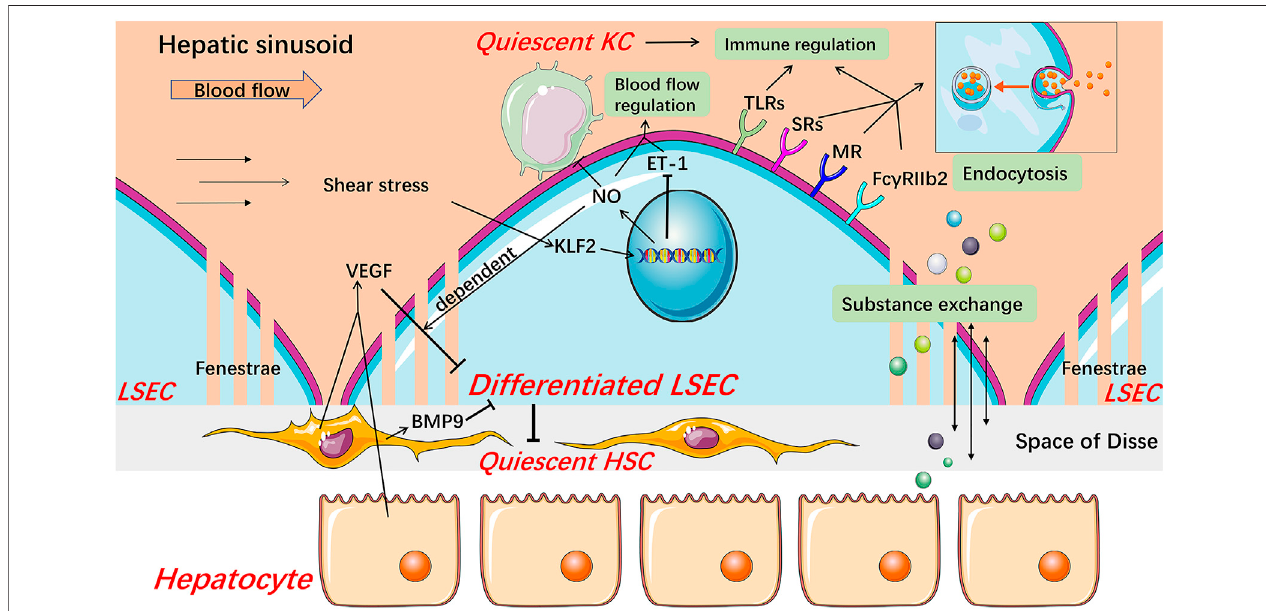
FIGURE 1 | Structure and major physiological function of LSECs. Healthy differentiated LSECs, characterized by the fenestrated phenotype and lack of basement membrane, are located at the junction of circulating blood and liver parenchyma, which state is maintained by VEGF from hepatocytes and HSCs in an LSEC-derived NO-dependent manner and BMP9 from HSCs. LSECs increase NO production and reduce ET-1 expression through KLF2 in response to the shear stress in hepatic sinusoids,therebyregulatingblood fl ow.NOalsokeepsKCsandHSCsquiescent.LSECsfenestraeconstituteasieveplatethatmakesLSECshighlypermeableto better exchange substance between liver parenchyma and blood. The expression of SRs, MR, and Fc γ RIIb2 endows LSECs with high endocytic capacity. These receptors, along with TLRs, are related to the immunoregulatory function of LSECs which contributes to the immune clearance and antigen presentation of LSECs. BMP9 Bonemorphogeneticprotein9, ET-1 endothelin-1, Fc c RIIb2 Fcgamma-receptorIIb2, HSC hepaticstellatecell, KC Kupffercell, KLF2 Kruppel-likefactor2, LSEC liver sinusoidal endothelial cell, MR mannose receptor, NO nitric oxide, SRs scavenger receptors, TLRs Toll-like receptors, VEGF vascular endothelial growth factor.